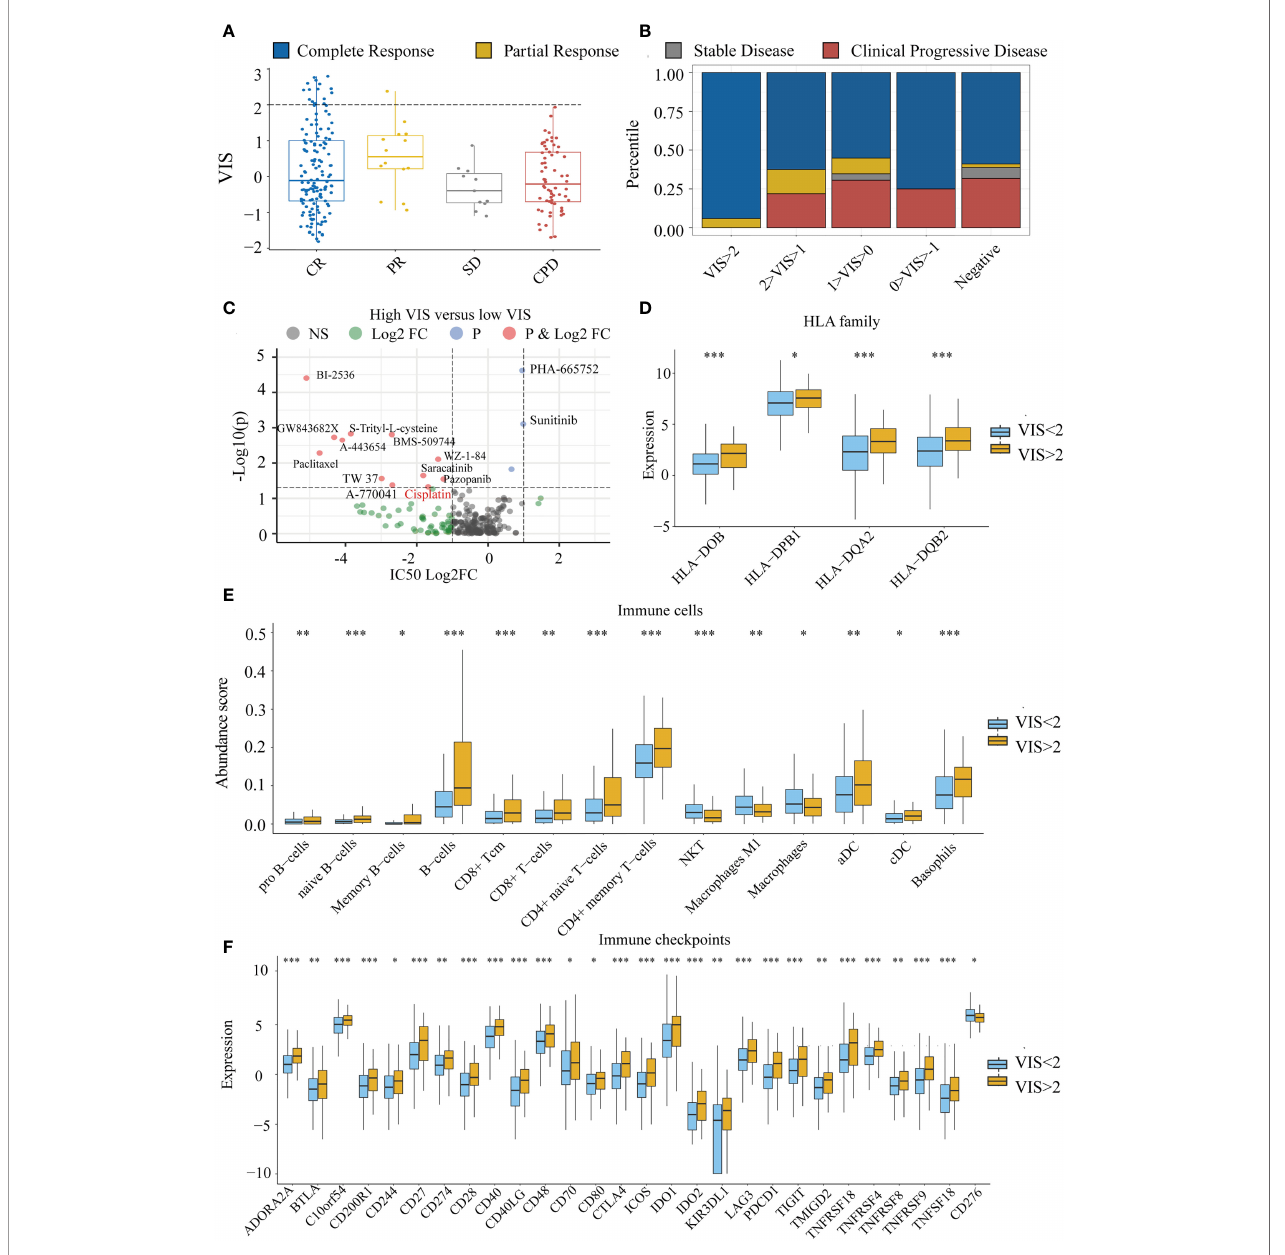
FIGURE 6 | The connection between VIS and drug response. (A) Distribution of scaled VIS levels for TCGA stage III and stage IV samples according to the RECIST standard. (B) Proportion of chemotherapy response in different groups segmented by scaled VIS. (C) Differences in drug IC50 values between high- and low-scaled VIS groups in the GDSC cell line data. (D – F) Show the signi fi cant differences in HLA family expression, immune cell in fi ltration, and immune checkpoint gene expression between high- and low-scaled VIS groups. All the p values of nonparametric test have been corrected by FDR (* represent fdr < 0.05, ** represent fdr < 0.01 and *** represent fdr <